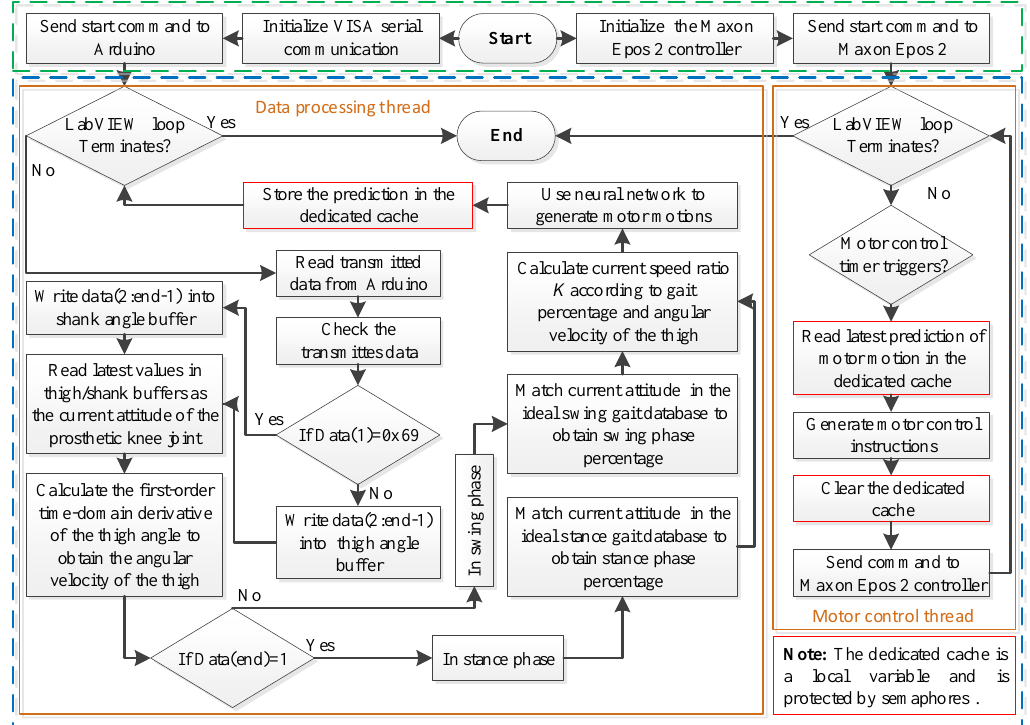
Figure 14. Overall control of the powered GFB prosthetic knee.